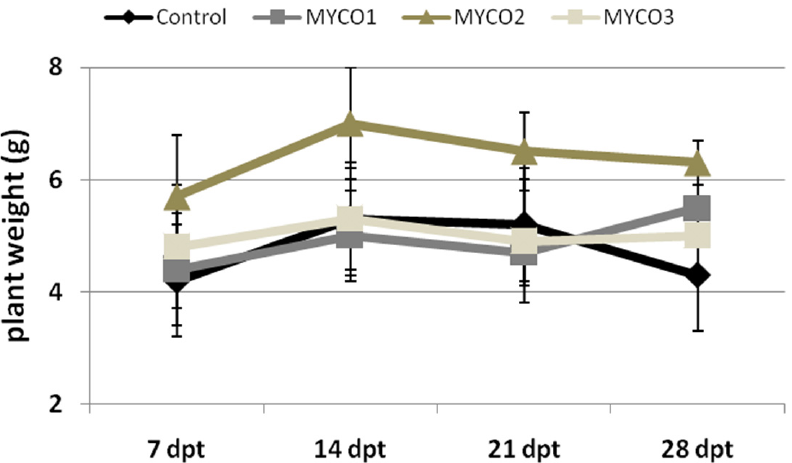
Figure 1. Weights of tomato plants untreated (Control) and treated with 3 different doses of a formulate containing AMF (Myco1, Myco2, Myco3), at 7, 14, 21, and 28 days after treatment. At 28 dpt, we checked if higher growth rate of treated plants was determined by AMF colonization of roots. At that time after treatment, roots of plants soil-drenched with all the tested doses were found infected by AMF, as shown in Figure 2.